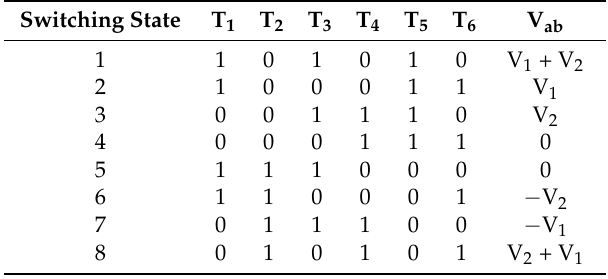
Table 1. All possible switching states and voltage levels of MPUC inverter.